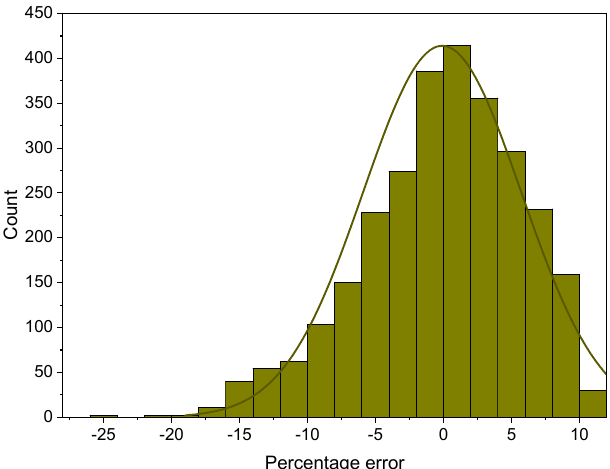
Figure 12. Histogram of the percentage error of the empirical model used for data validation.